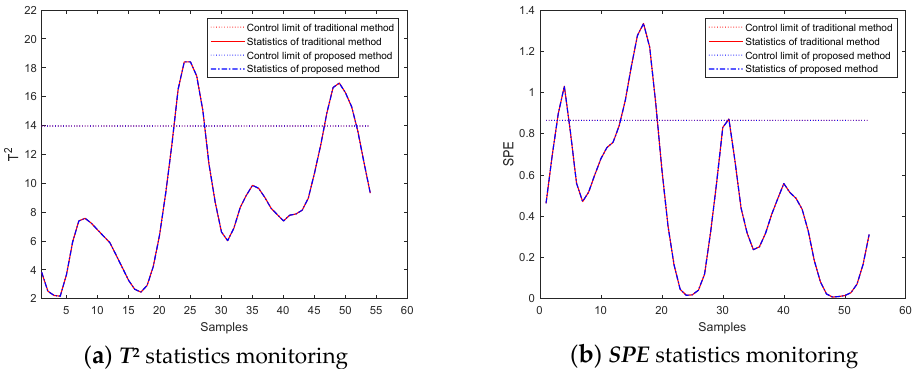
Figure 16. Multi-mode online monitoring of injection phase of mode 1.